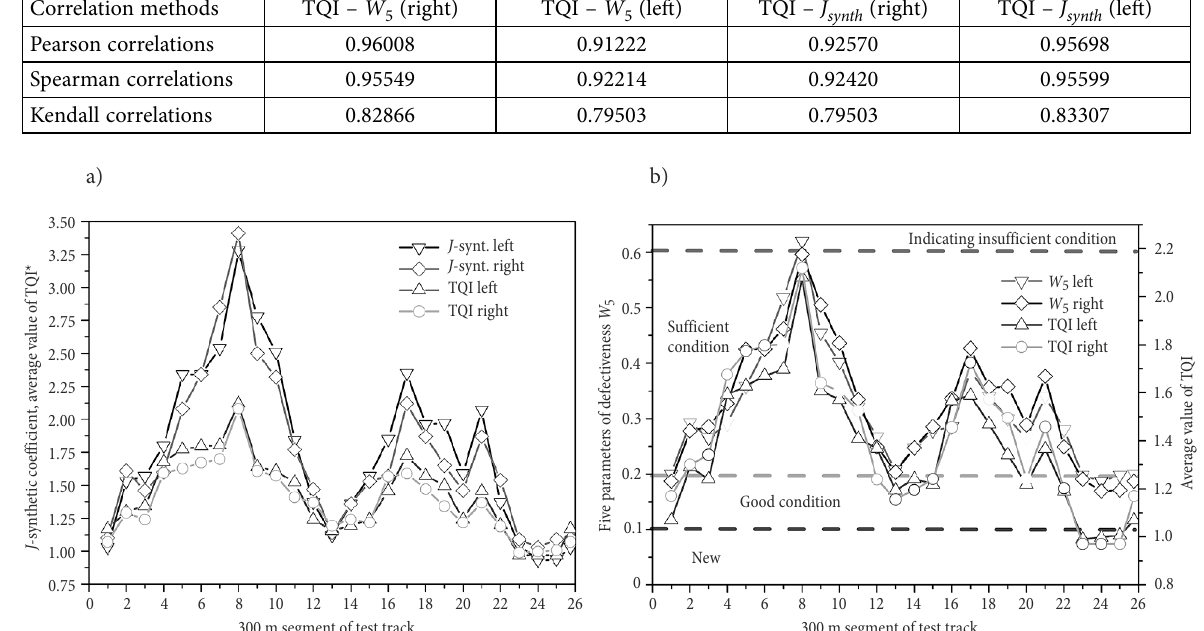
Table 4. Comparison of correlation between TQI – W 5 and TQI – J synth synthetic coefficient Correlation